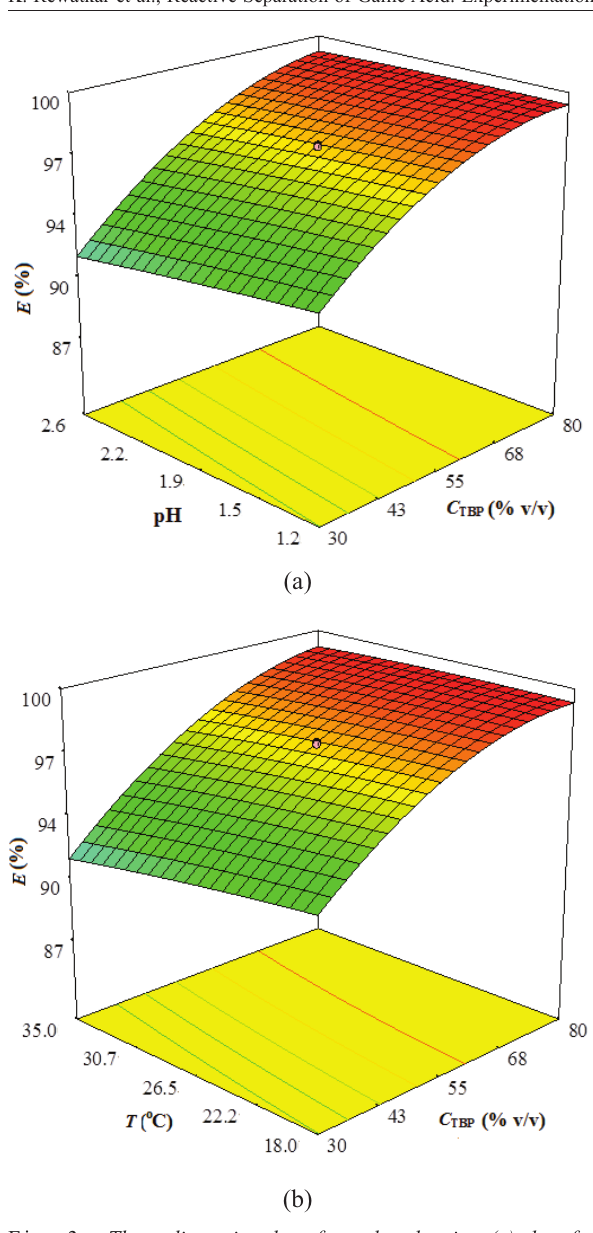
Fig. 3 – Three dimensional surface plot showing (a) the ef- Fig. 3 Three dimensional surface plot showing (a) the effect of C TBP and pH 0 on the extraction fect of C and pH on the extraction of GA at the centre level TBP 0 (T = 26.5 o C, C = 1.4 g L –1 ), and (b) the effect of C GA0 on the extraction of GA at the centre level (pH of GA at the centre level ( T = 26.5 o C, C GA0 = 1.4 g L -1 ), and (b) the effect of C TBP and T on 1.4 g L –1 ). the extraction of GA at the centre level (pH 0 = 1.9, C GA0 = 1.4 g L -1 ).